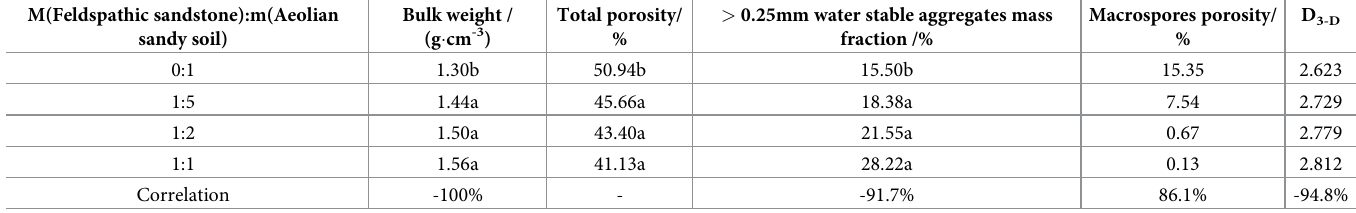
Table 1. Structural parameters of applying different amounts of soft rock. M(Feldspathic sandstone):m(Aeolian sandy